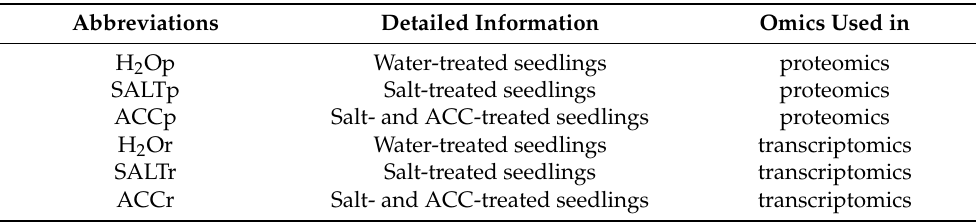
Table 1. The abbreviations of quinoa samples used in this